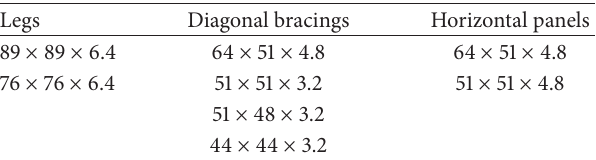
Table 4: Cross section dimensions of studied tower number 1